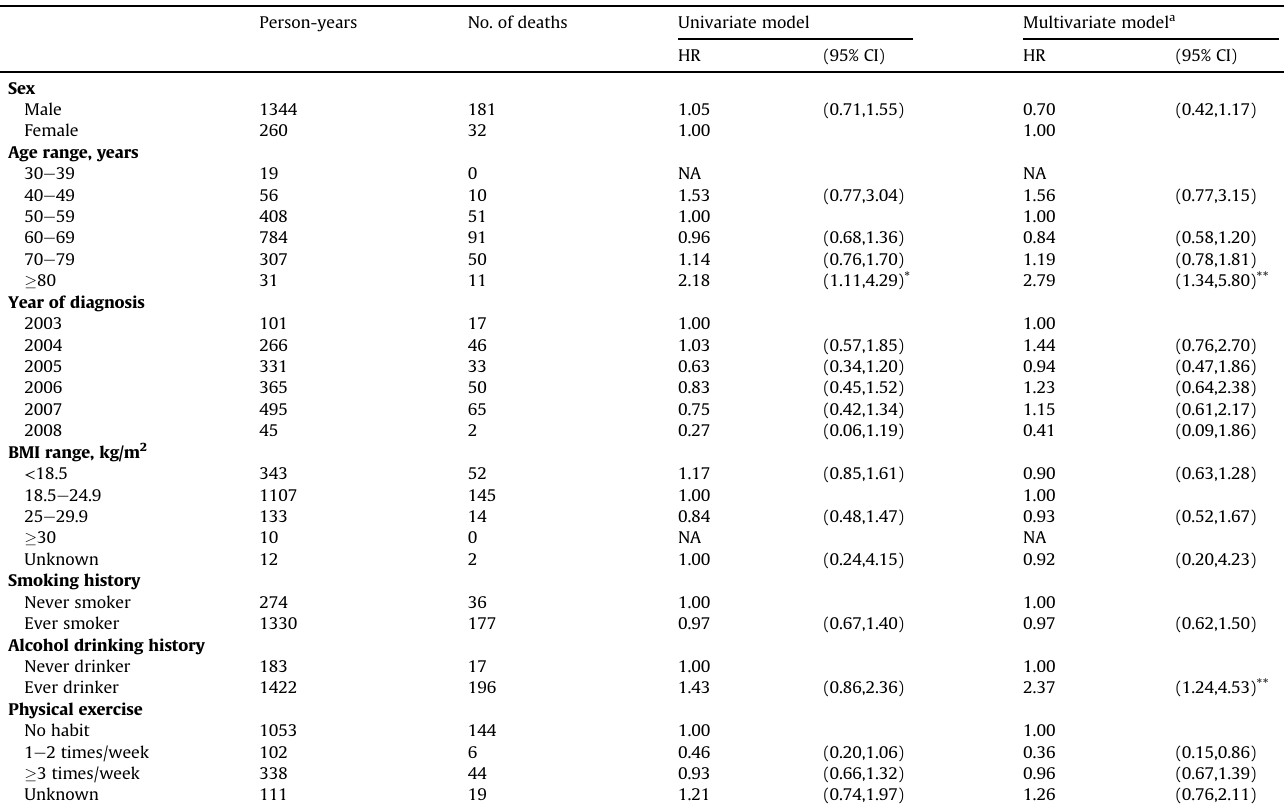
Table 3 HRs and 95% CIs for mortality according to demographic and lifestyle factors among patients with ESCC in the Biobank Japan Project (n ¼